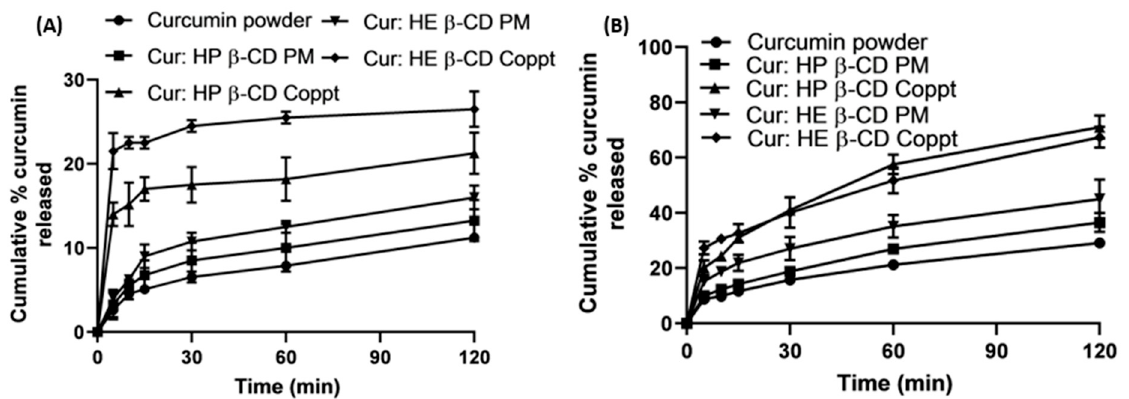
Figure 6. In vitro curcumin dissolution from curcumin alone and some selected physical (PM) and coprecipitated (Coppt) with HP β -CD and HE β -CD in simulated gastric fluid ( A ) and simulated intestinal fluid ( B ). Results presented as mean ± SD, n = 3. Table 2. In vitro dissolution parameters (Q 10min and Q 120min ) estimated for curcumin and some selected curcumin: cyclodextrins, PM, and Coppt. Results represent mean ± SD, n = 3.